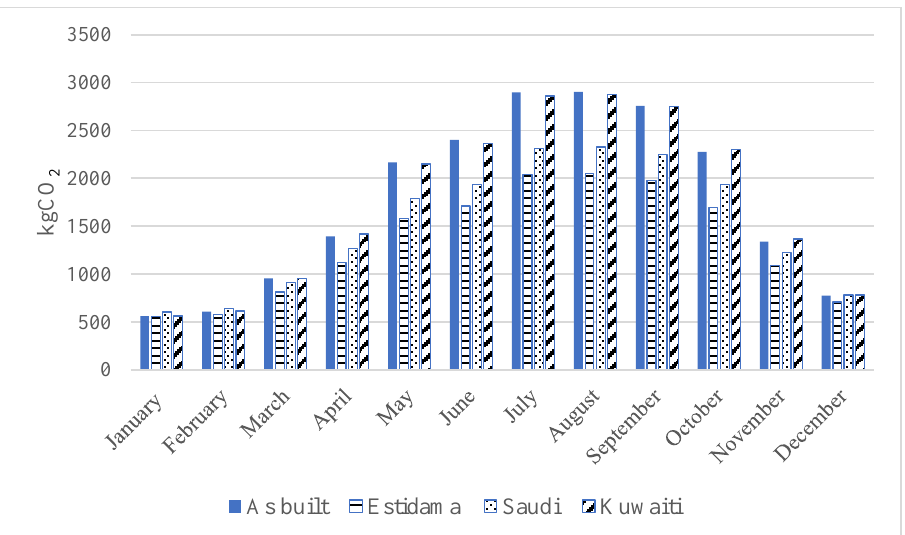
Figure 10. Monthly carbon emissions for the four cases.